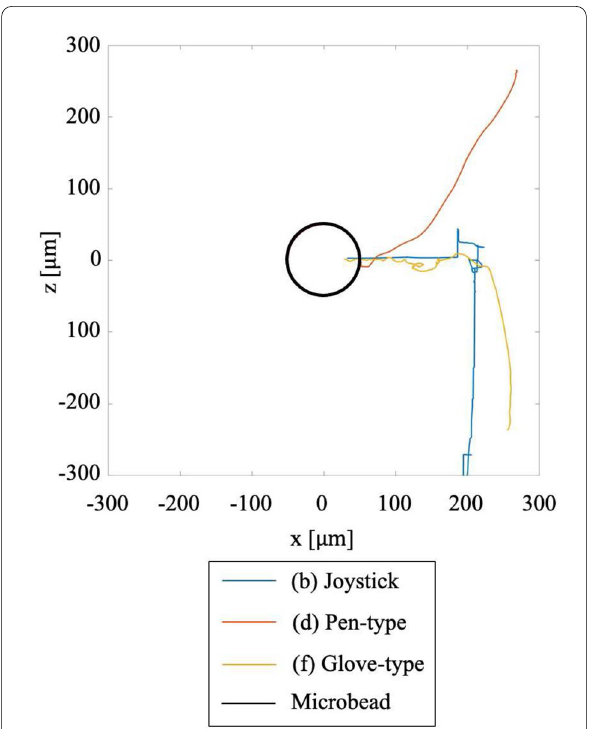
Fig. 24 Trajectoriesin the yz -plane with 3D image presentation for the evaluation of operation